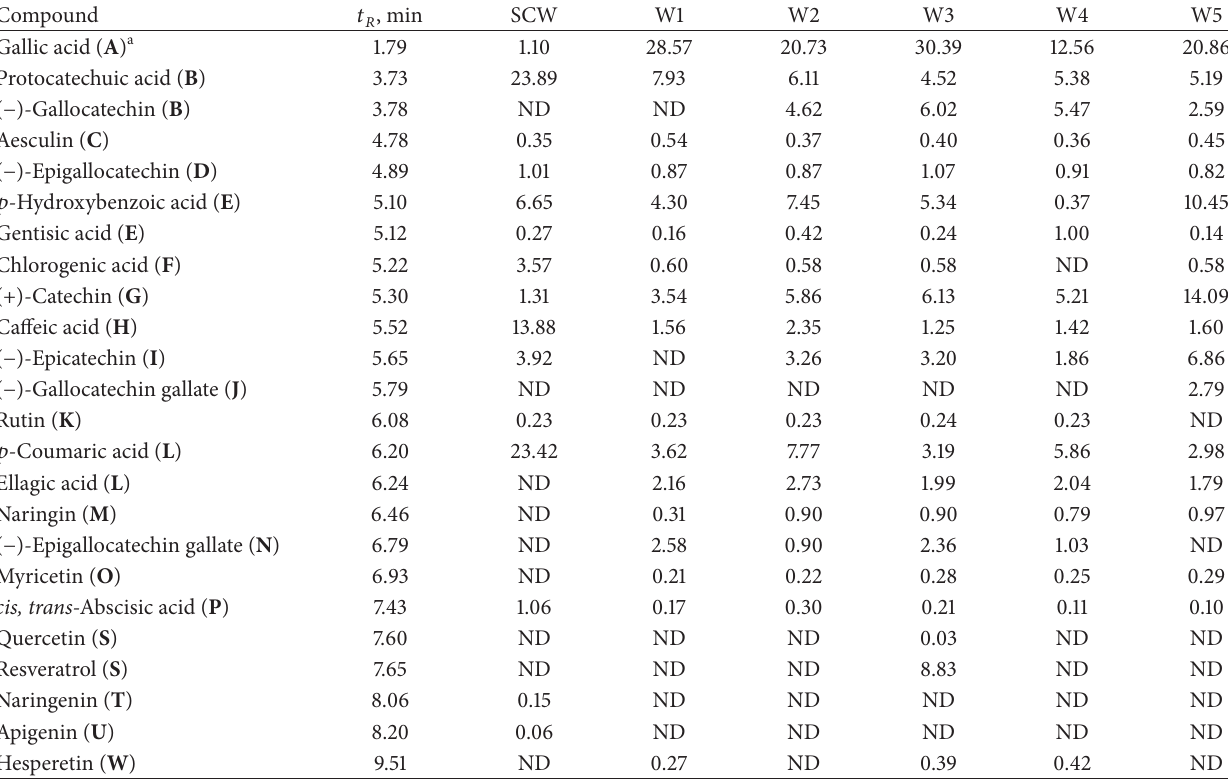
a Corresponding to Figure